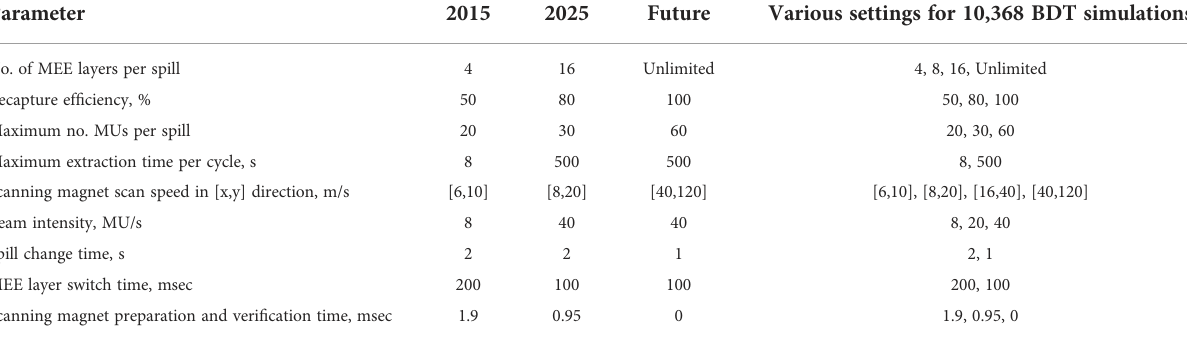
TABLE 2 Operating parameters of 2015, 2025, and hypothetical future synchrotron-based proton pencil beam spot scanning systems. Parameter